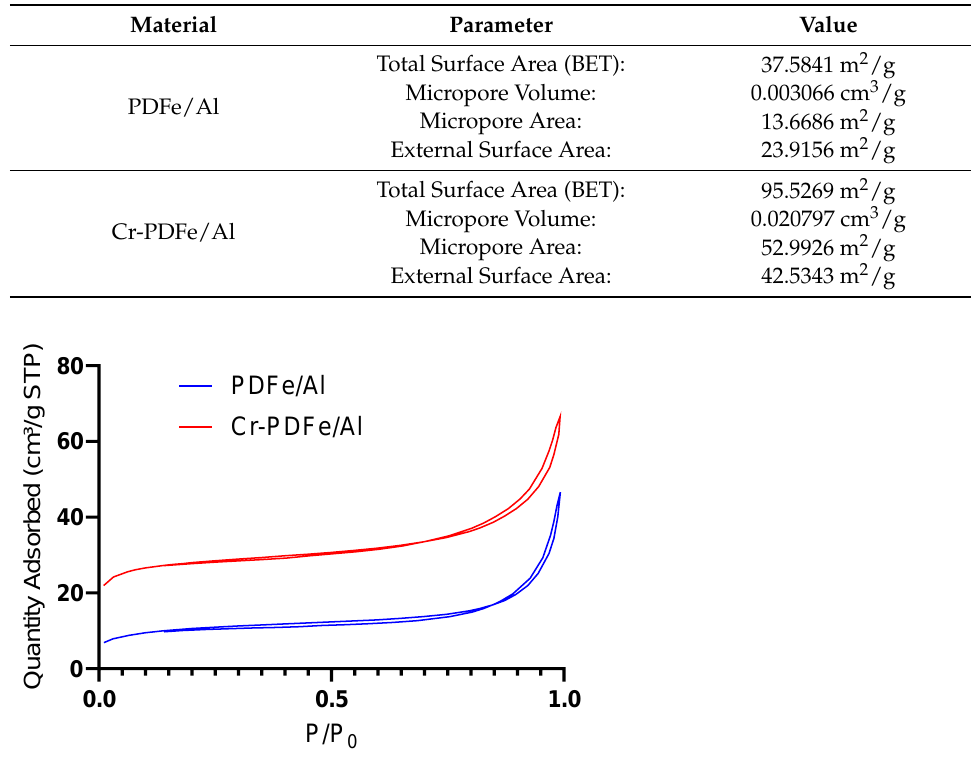
Figure 6. The nitrogen adsorption–desorption isotherms of the synthesized PDFe/Al before and after Cr(VI) adsorption.